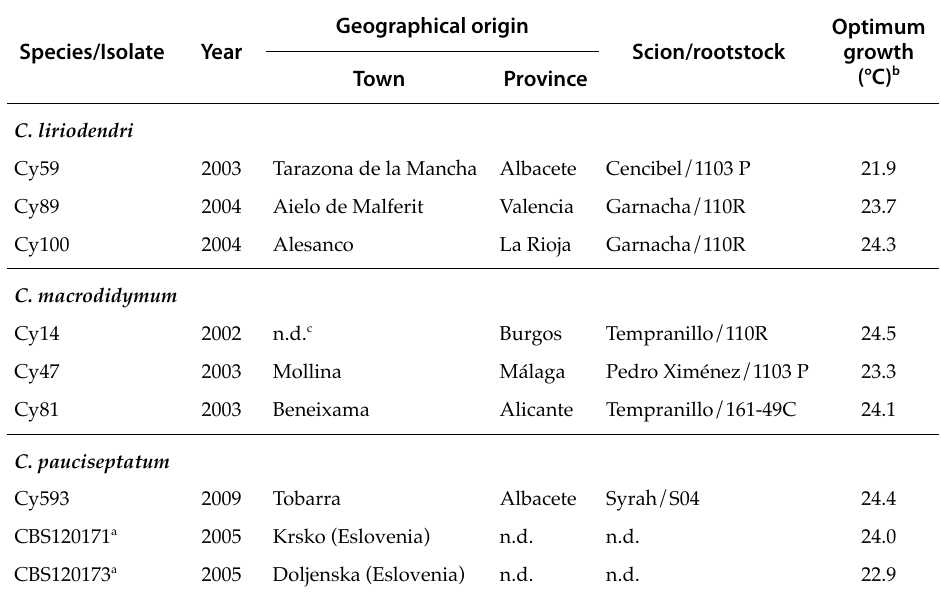
Table 1. Sources of isolates of Cylindrocarpon spp. associated with black foot disease and their optimum growth tempera -